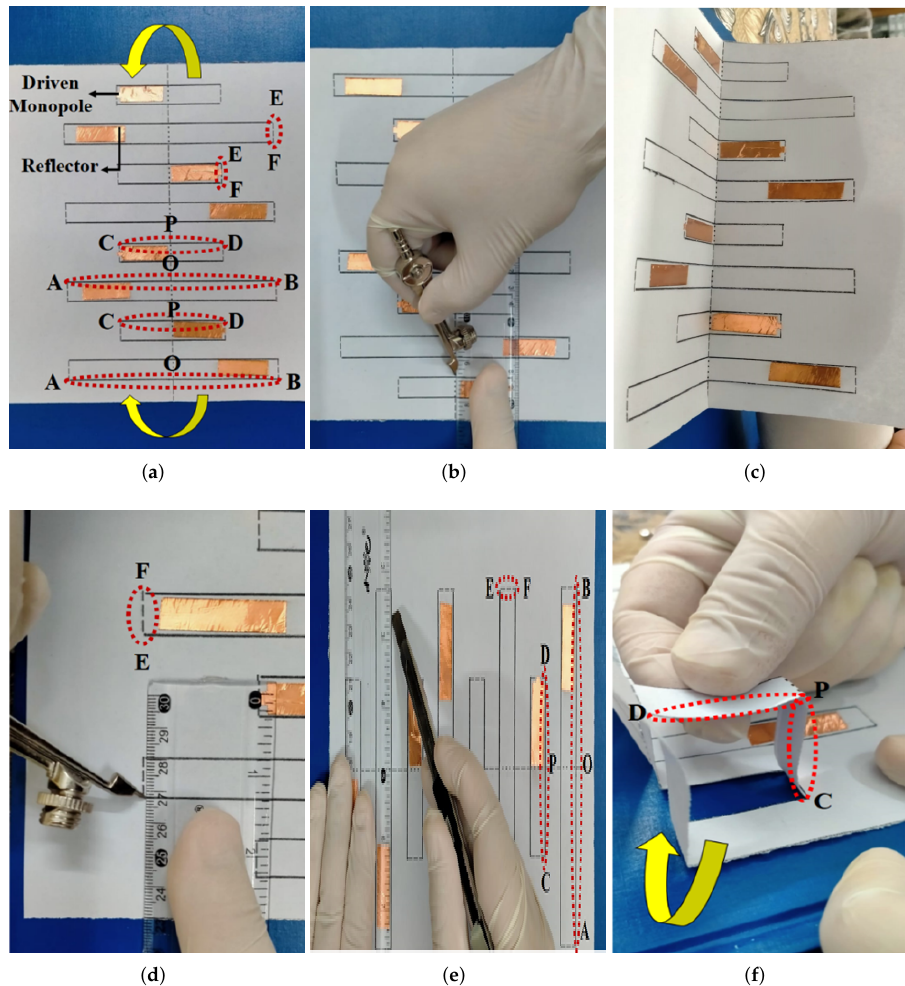
Figure 2. Fabrication steps for the Kirigami MIMO antenna system: ( a ) printed patterns and copper film; ( b ) cut vertical lines; ( c ) folded in half; ( d ) vertical slicing; ( e ) horizontal slicing; ( f ) folded along the horizontal lines to form a staircase geometry.